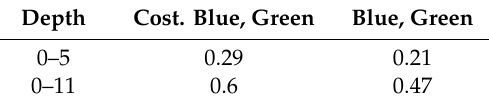
Table 1. The mean absolute deviation (MAD) (m) of different depth ranges and band combinations for UDB with Stumpf’s model.